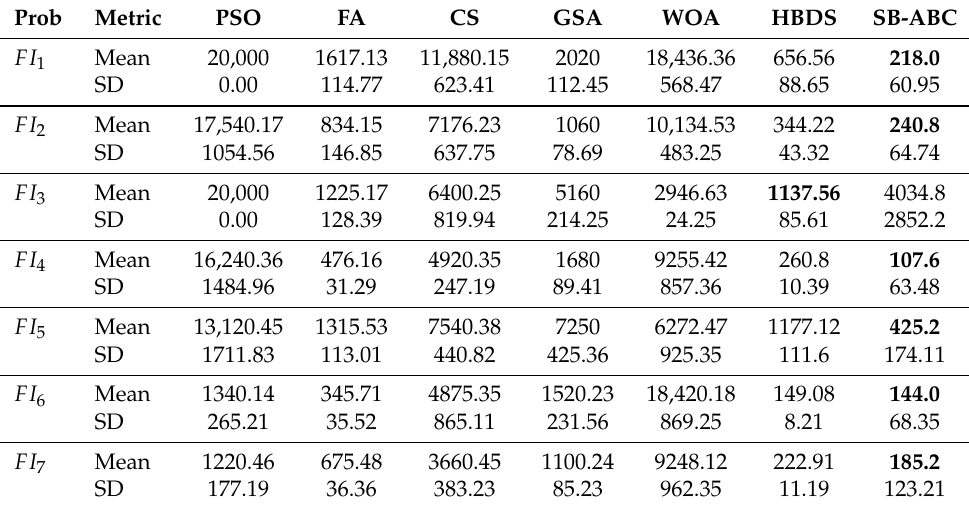
Table 4. Comparison results of the PSO, FA, CS, GSA, WOA, HBDS and SB-ABC for the FI 1 – FI 7 integer programming